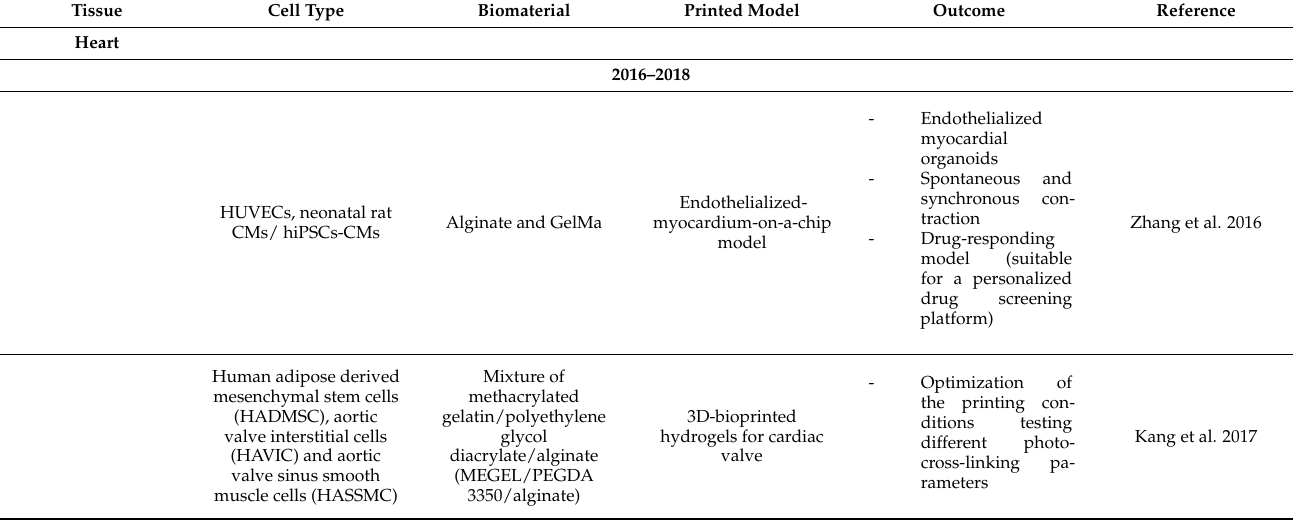
Table 2. Remarkable achievements in 3D bioprinting of cardiovascular tissue. Articles from 2016 to 2018 and from 2019 to 2020.